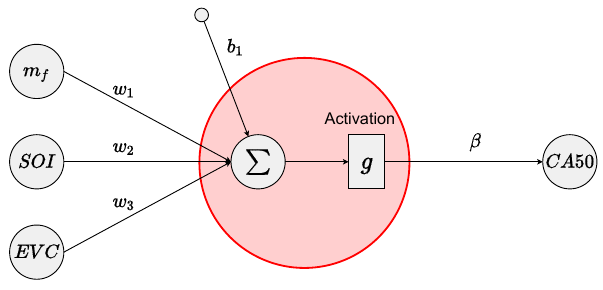
Figure 17. Modeling CA50 using